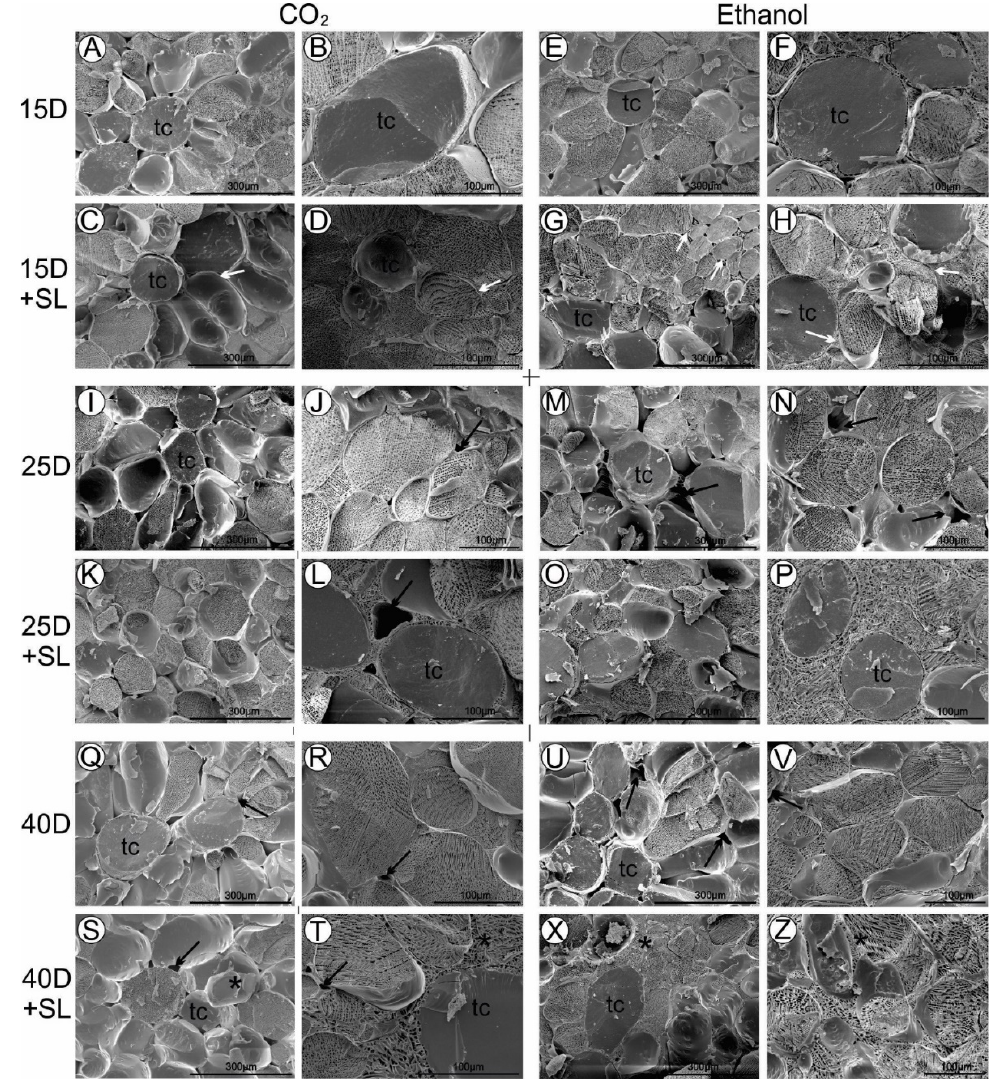
Figure 4. The ‘Giombo’ persimmon images obtained by cryo-scanning electron microscopy (Cryo- SEM) throughout storage after treatment with CO 2 ( A – D , I – L , Q – T ) or ethanol ( E – H , M – P , U – Z ). Black arrow: cell separation and spaces formation. White arrow: soluble material in intercellular spaces. TC: tannin cell. *: cell wall degradation. Vertical columns: Deastringency treatments. Hori- zontal columns: Days (D) of storage at 0 °C or Days of storage at 0 °C plus shelf life (SL) (5 days at 20 °C).